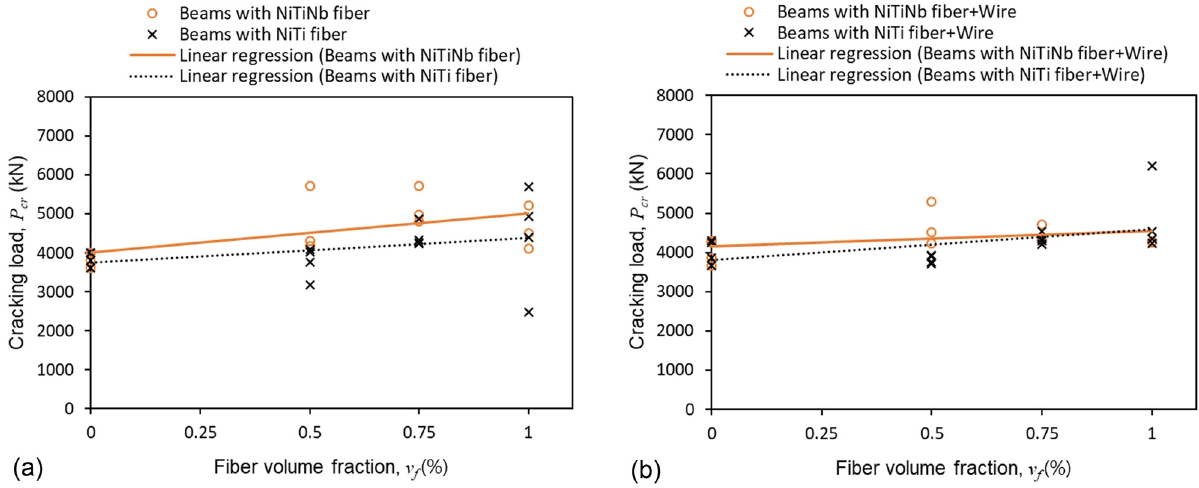
Figure 5: Cracking loads of the beam specimens with fi ber volume fractions: ( a ) beam specimens without tensile wires and ( b ) beam specimens with tensile wires.